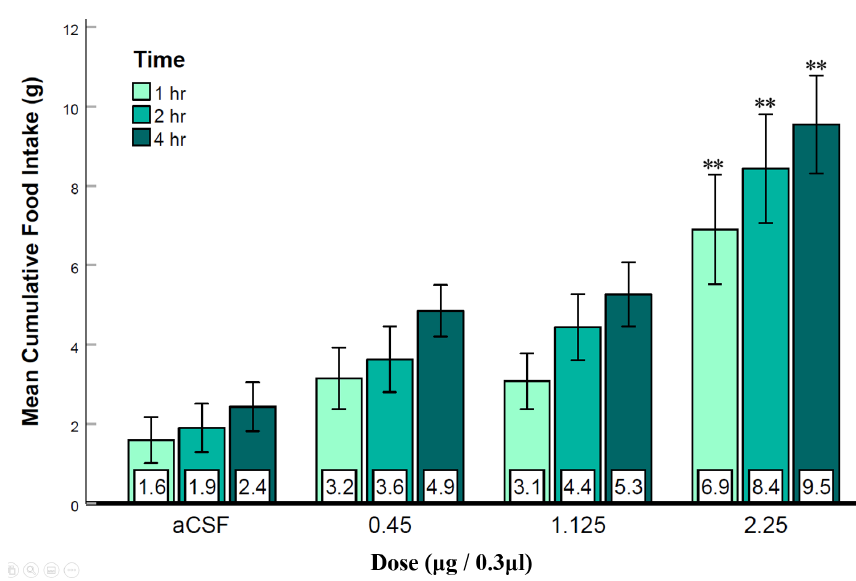
Figure 3. Baclofen injection into the LS during the light phase rapidly elicited eating. Error bars: ±SEM; n = 13; mean values are shown at the bottom of the bar. ** indicates significant differences from the aCSF group at p < 0.01.